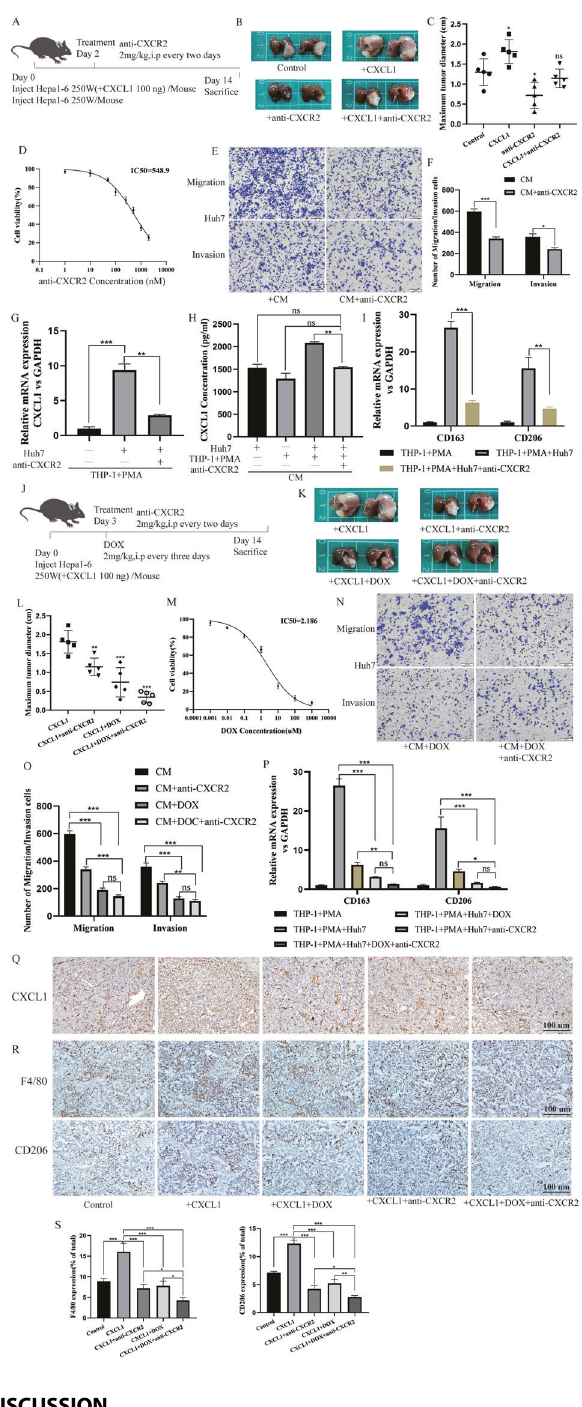
leads to the malignant progression of liver cancer and limits the effects of systemic treatment [7, 14]. Acting as a key effector and cytokine manufacturer, macrophages play a key role in regulating liver fi brosis, cirrhosis, carcinogenesis, EMT and metastasis [13]. Here, we found that CXCL1, a common chronic hepatitis-related cytokine, exerts protumour effects in HCC by affecting macro- phages chemotaxis through the CXCL1-CXCR2 loop. Previous studies have shown that CXCL1 is a proin fl ammatory cytokine in various viral and nonviral hepatitis types and is positively correlated with chronic hepatocyte injury and the